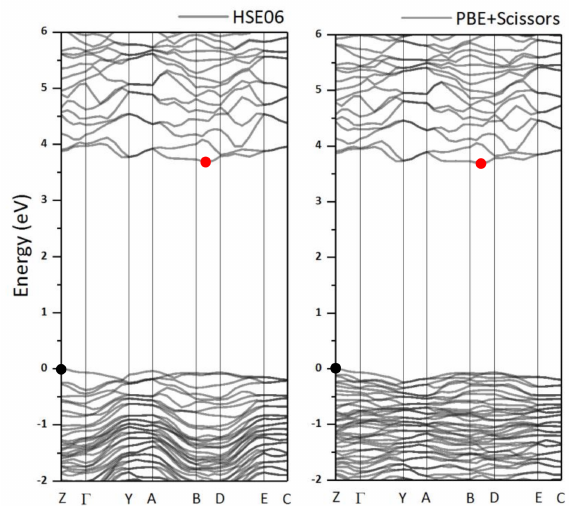
Figure 7. Band structure of LiAl(IO 3 ) 4 , as calculated by HDE06 ( left ) and PBE with the scissor parameter ( right ). The red and the black dots represent the top of the valence band and the bottom of the conduction band,